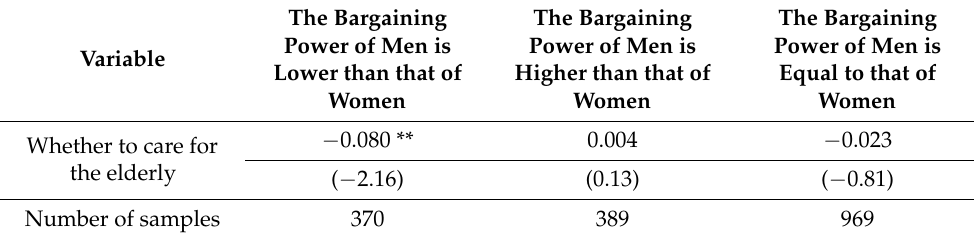
Table 5. Estimation results of bargaining power difference (without considering endogeneity). The Bargaining The Bargaining The Bargaining Power of Men is Power of Men is Power of Men is Variable Equal to that of Higher than that of Lower than that of Women Women Women − 0.080 ** 0.004 − 0.023 Whether to care for the elderly (0.13) ( − 0.81) Number of samples 370 389